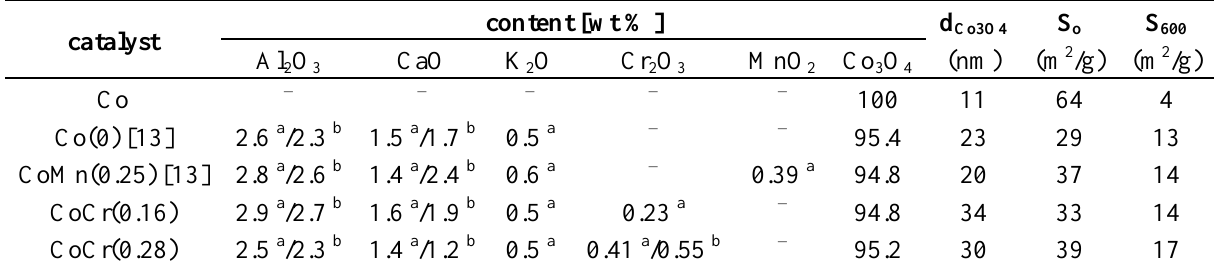
Table 1. Chemical composition and specific surface areas of the